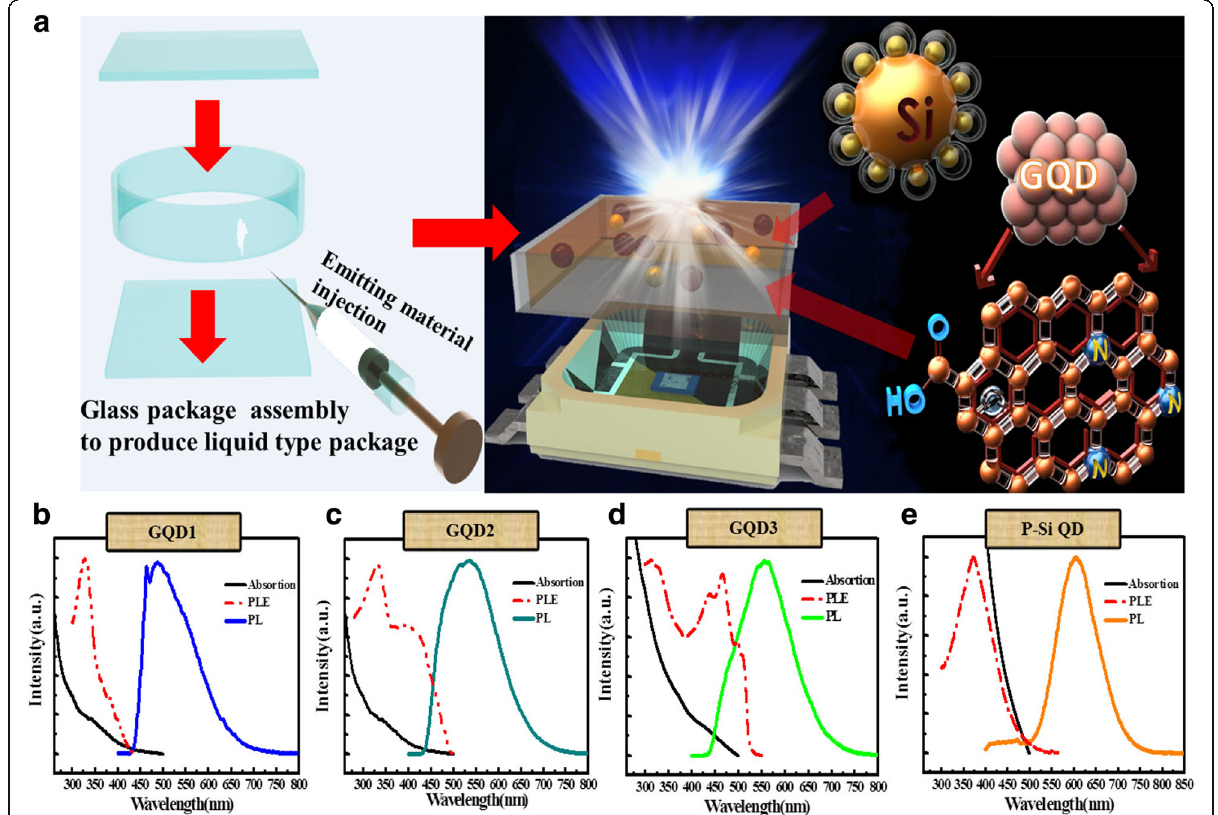
Fig. 1 Top panel: a (left) glass package assembly showing a liquid-type P-Si QD and a nitrogen-doped GQD and (right) a network of P-Si QDs and nitrogen-doped GQDs. Bottom panel: absorption (black solid line), PL excitation (dashed line), and PL emission (solid line) spectra of b GQD1, c GQD2, d GQD3, and e P-Si